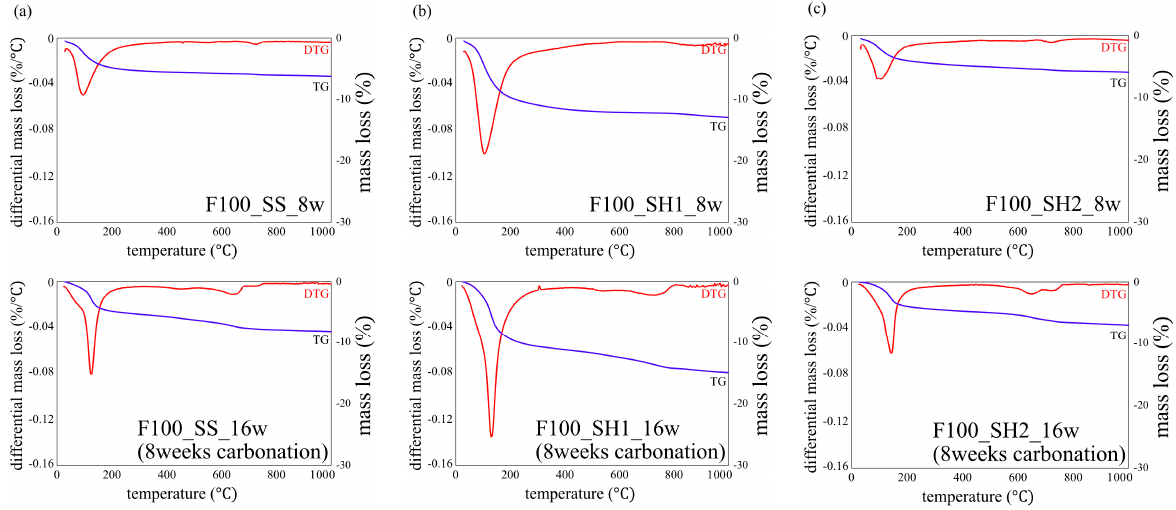
Figure 10. Thermogravimetric/differential thermal gravimetric (TG/DTG) analysis results for specimens of ( a ) F100_SS_8w